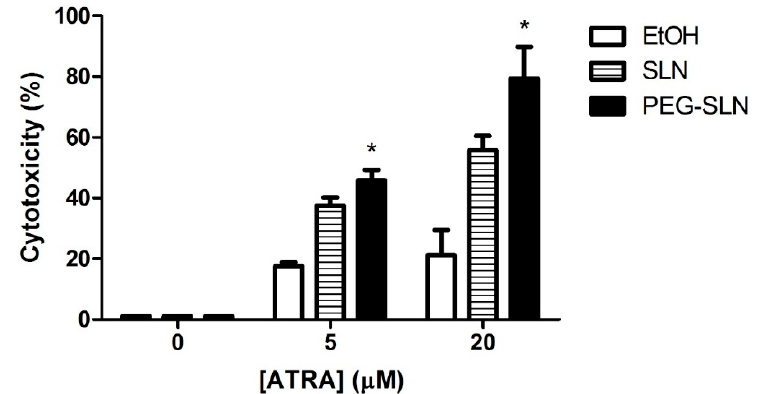
Figure 7. Cytotoxic effect of all-trans retinoic acid (ATRA) applied in different vehicles. SCC-25 cells were seeded (1.5 × 10 4 cells/well) in 96-well plates. The next day, different concentrations of ATRA was added: dissolved in ethanol (empty bars), incorporated SLN (stripped bars) or incorporated PEG–SLN (black bars) and cells were incubated for 72 h. Cytotoxicity was measured using lactate dehydrogenase (LDH) method and cell viability was determined as described in Materials and Methods section. Results are expressed as the mean ± SEM of four independent experiments (* p < 0.05 PEG–SLN-treated values versus SLN-treated values).